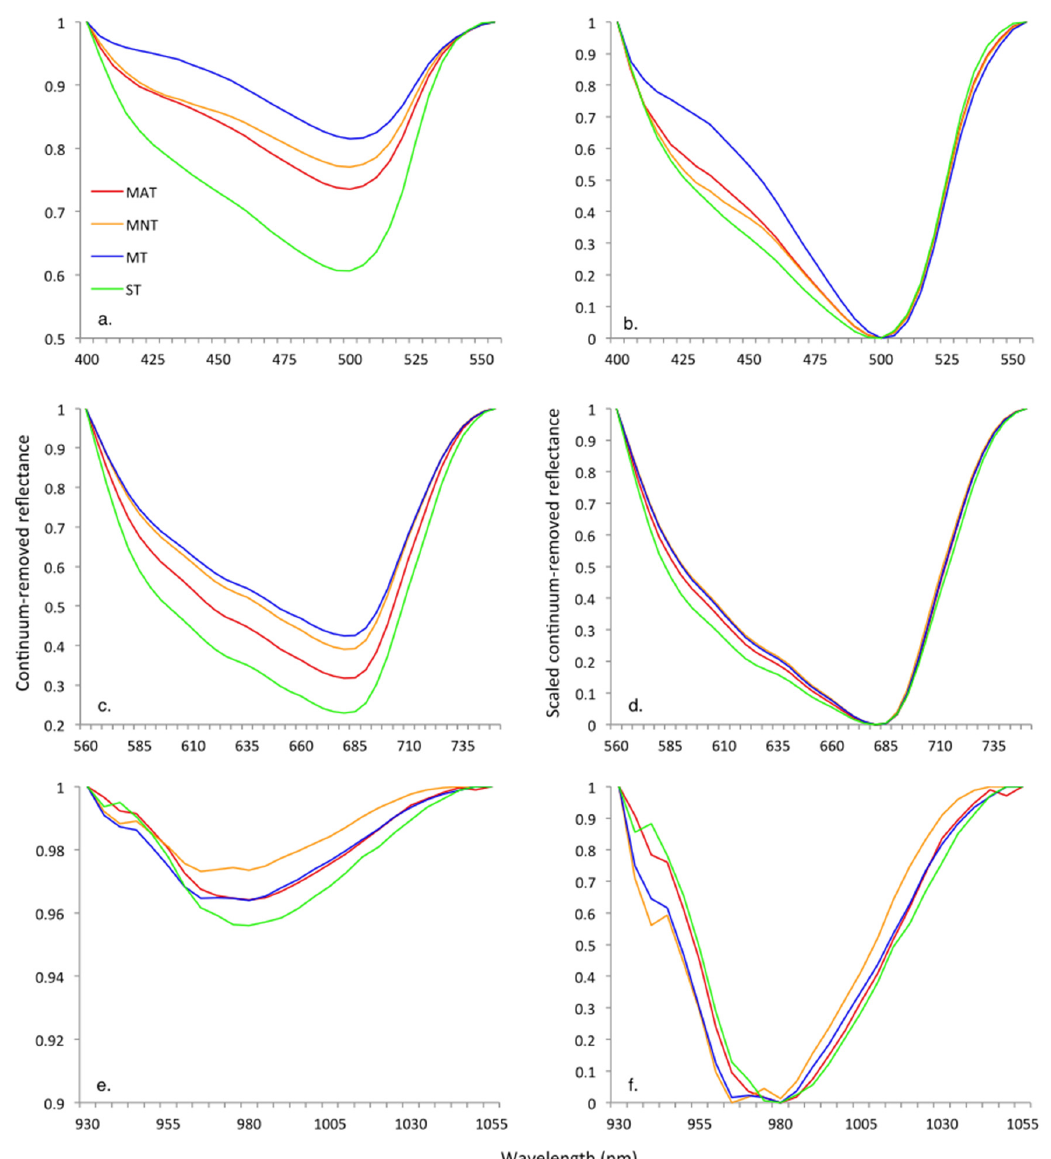
Figure 6. Average continuum-removed and scaled continuum-removed reflectance spectra at Ivotuk, Alaska for the blue ( a , b ), red ( c , d ), and water ( e , f ) absorption features during early growing season.